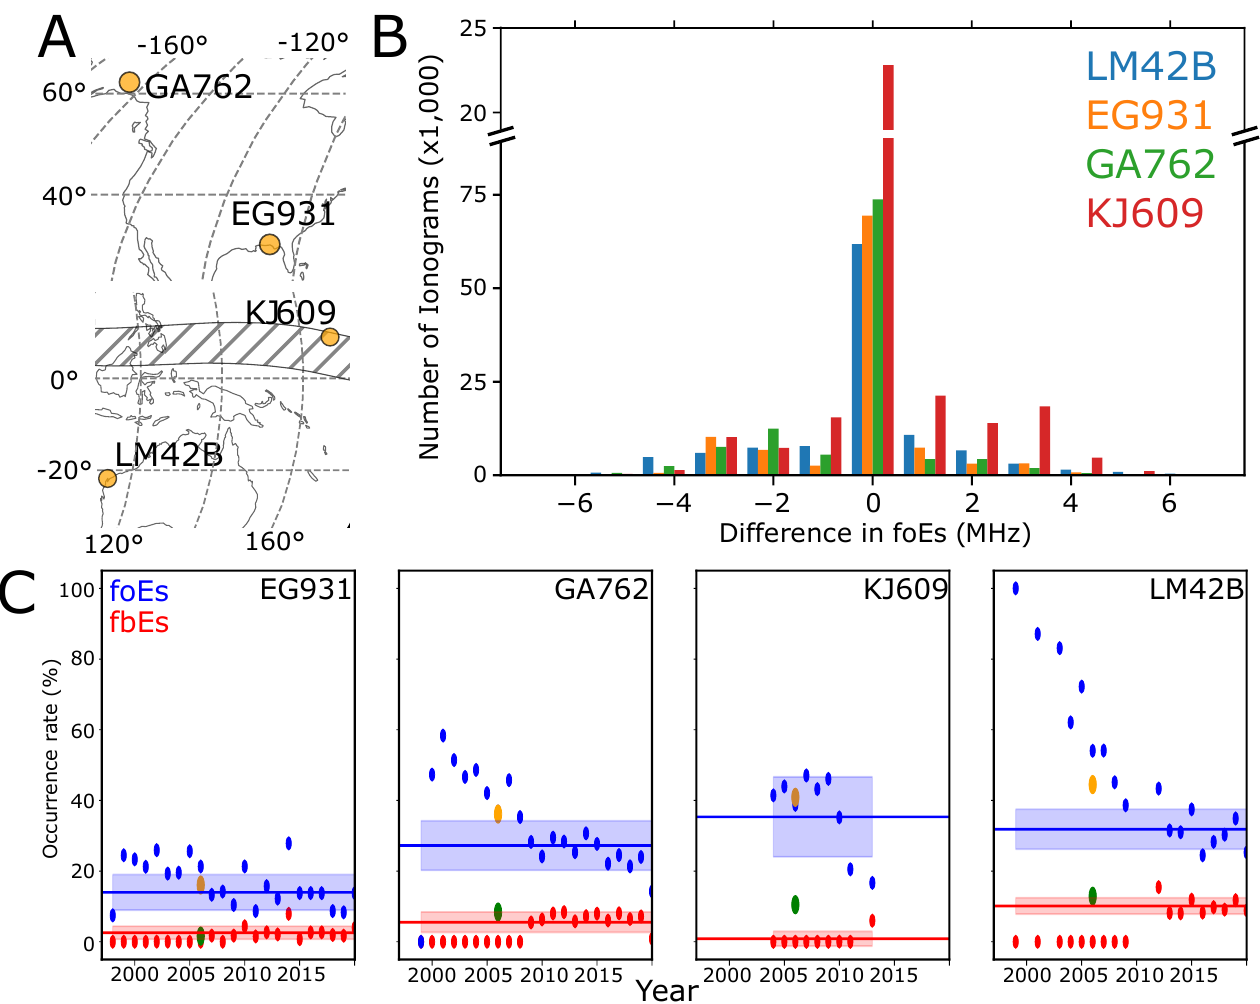
Figure 4. ( A ) Map showing the four sites used in the analysis. ( B ) Histogram of the four sites and the difference in foEs between ARTIST4/4.5–ARTIST5. ( C ) Yearly occurrence rates calculated using only using data from March, June, September, and December for foEs (blue) and fbEs (red). The straight line represents the average occurrence rates with the lightly shaded regions representing the standard deviation over available data. In 2006, the additional bold dots represent updated occurrence rates recalculated using ARTIST-5 in SAOExplorer